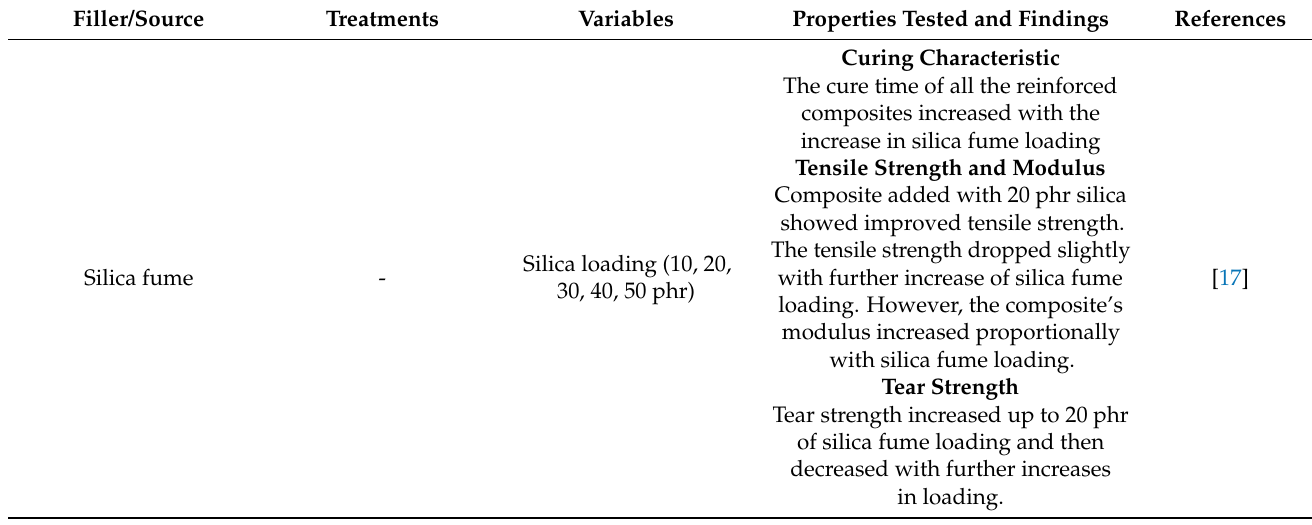
Table 2. The summary of literatures using silica as main fillers for rubber composite.